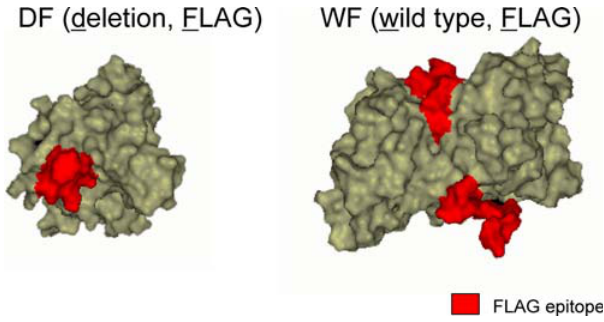
Figure 1. Computer assisted simulation of the FLAG-tagged SOD1 proteins. Simulation models of the FLAG-tagged SOD1s were constituted using Discovery Studio 1.7 software (Accelrys, USA) from Protein Data Bank (PDB) data; 1MFM for DF, 2V0A for WF as templates. The red parts indicate the FLAG epitopes. The DF mutant SOD1 possibly exposes a hydrophobic structure, which is normally buried by the dimer interface.